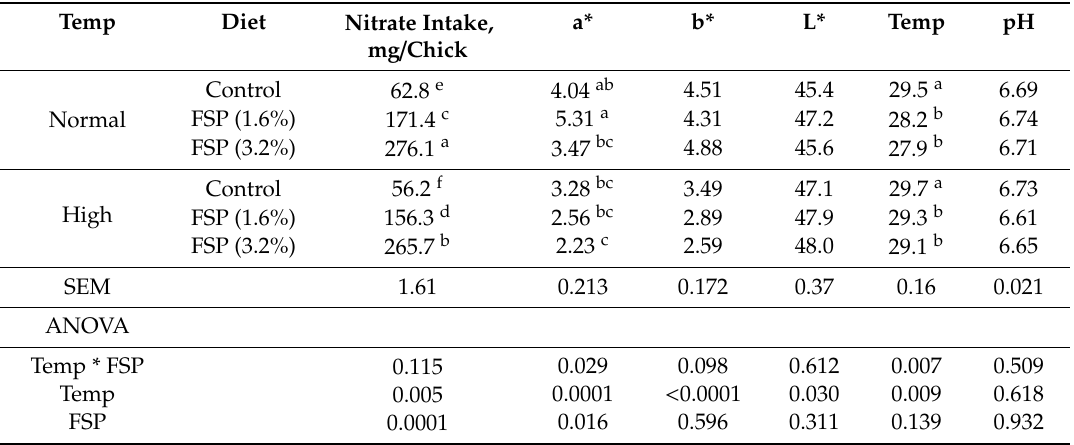
Table 4. Broiler meat quality a ff ected by supplementation with fennel seed powder under thermoneutral or heat stress conditions.